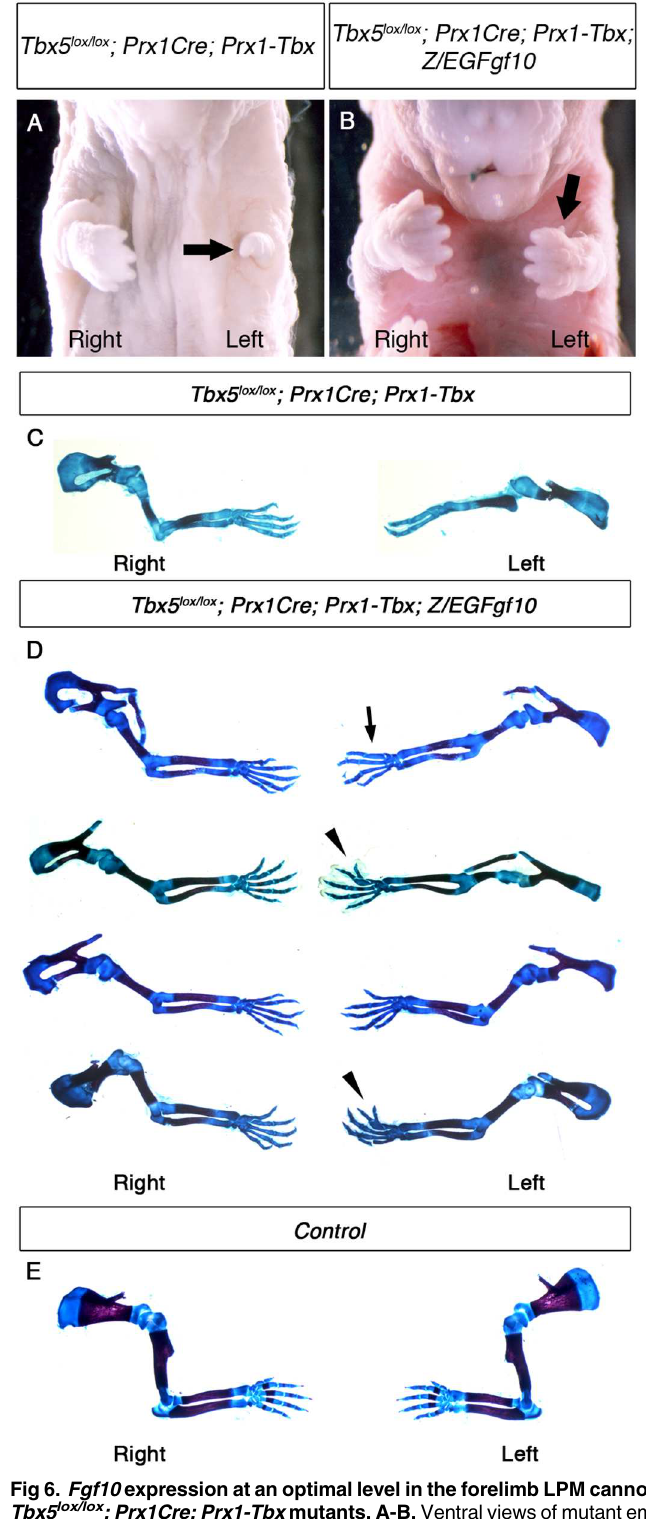
Fig 6. Fgf10 expression at an optimal level in the forelimb LPM cannot rescue asymmetric defects of Tbx5 lox/lox ; Prx1Cre;Prx1-Tbx mutants. A-B, Ventral views of mutant embryos at E17.5. The left forelimb is severely truncatedcomparedto the right in Tbx5 lox/lox ;Prx1Cre;Prx1-Tbx mutant (arrow) (A). Tbx5 lox/lox ; Prx1Cre;Prx1-Tbx;Z/EGFgf10 mutant lacks digit one in the left forelimb (arrow) (B). C-E,